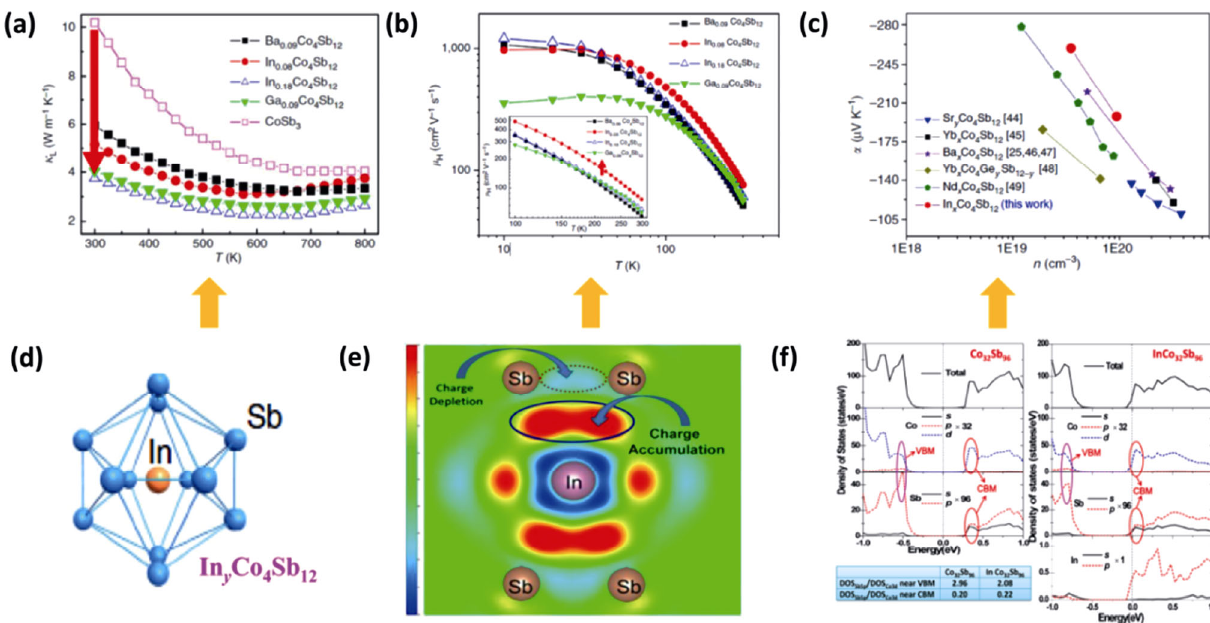
Fig. 16 Synergistic regulation of electrical and thermal transport properties in In y Co 4 Sb 12 TE materials. (a) Temperature dependences of lattice thermal conductivity for CoSb 3 and filled CoSb 3 in the range of 300–800 K; (b) temperature dependences of Hall mobility for filled CoSb 3 in the range of 10–300 K; the inset shows the temperature dependences of Hall mobility for filled CoSb 3 in the range of 100–300K; (c) carrier concentration dependences of the Seebeck coefficient of n-type filled CoSb 3 at room temperature; (d) filling Sb 12 icosahedron voids at the 2a sites; (e) differential charge density of In 0.125 Co 4 Sb 12 projected on the (111) plane; (f) total DOS and partial DOS near VBM and CBM of CoSb 3 and In 0.125 Co 4 Sb 12 . Reproduced with permission from Ref. [219], © Macmillan Publishers Limited